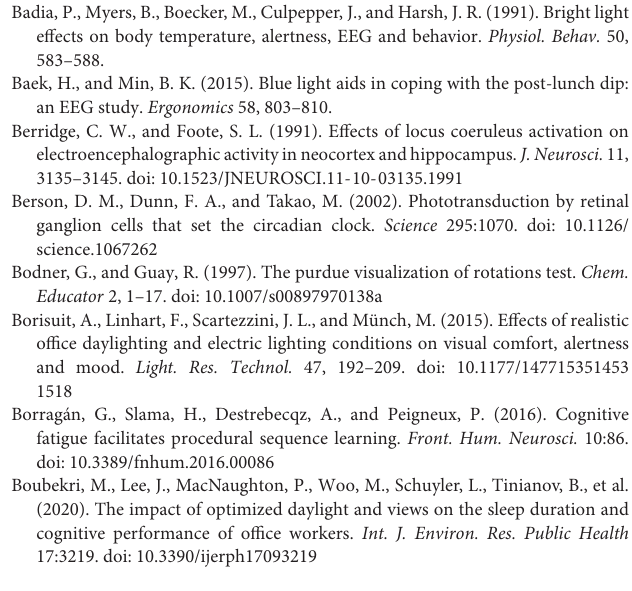
Supplementary Figure 1 | Risk of bias summary. Green denotes low